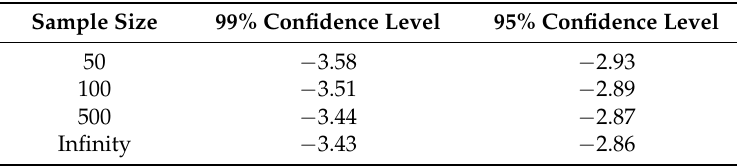
Table 1. Critical Values for Dickey-Fuller Test